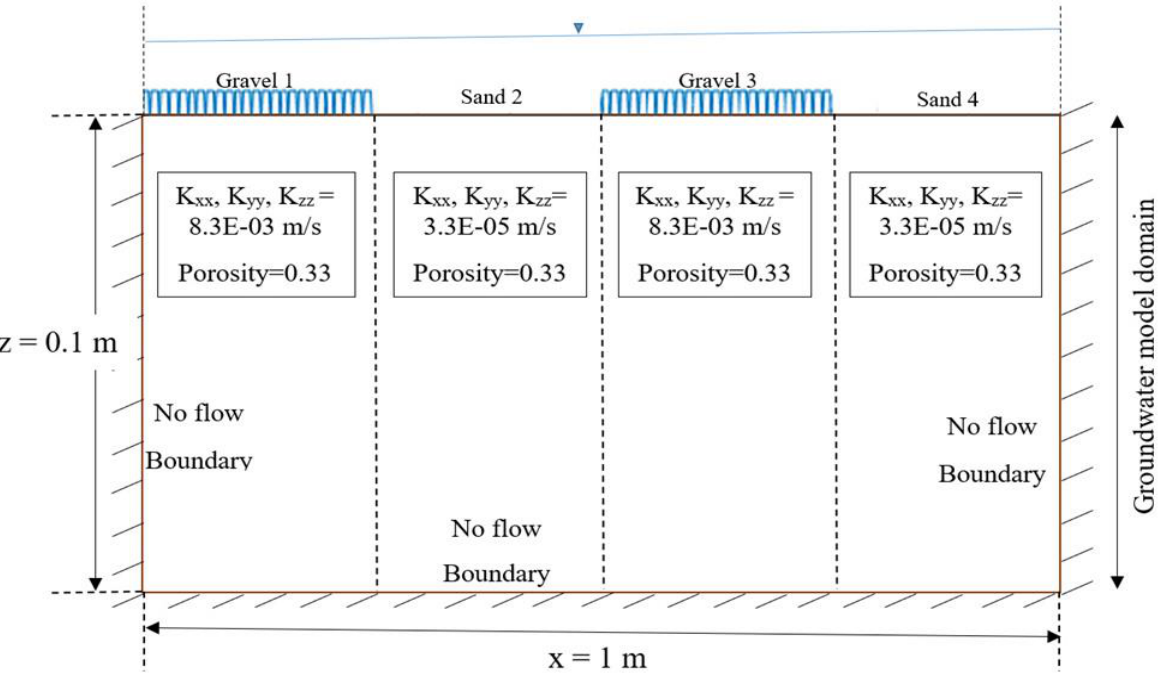
Figure 8. Subsurface water flow model domain with gravel/sand partitioning in streambed and subsurface